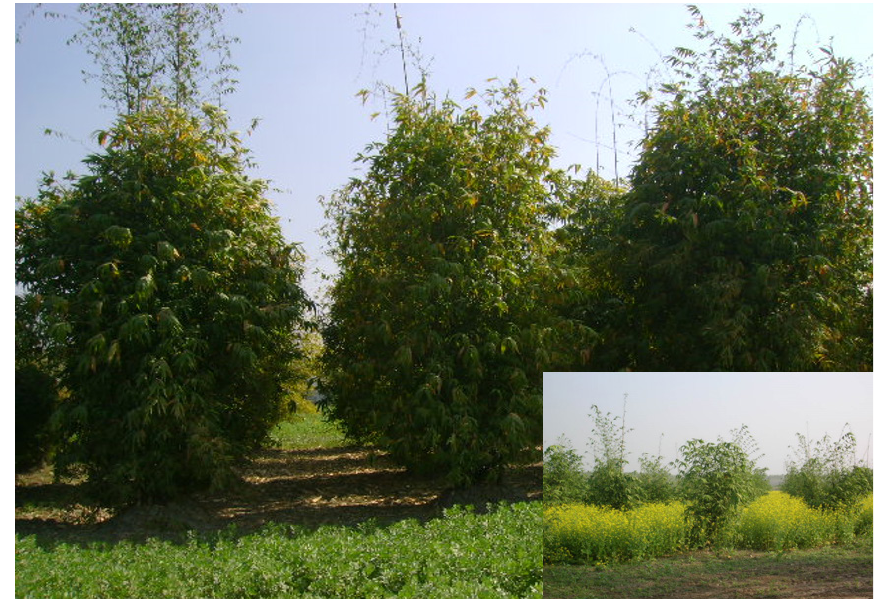
Figure 7: A plantation of Bambusa balcooa (a native clumping bamboo species) in India. It intercrops with mustard (inset). B. balcooa has many commercial uses including wood chip industry, building material, raw material for fishing and agricultural implements, paper pulp etc. Shoots are consumed as a vegetable and leaves as a fodder. © Prof. Salil Thewari, G.B. Pant University of Agriculture and Technology, Pantnagar, Uttarakhand,